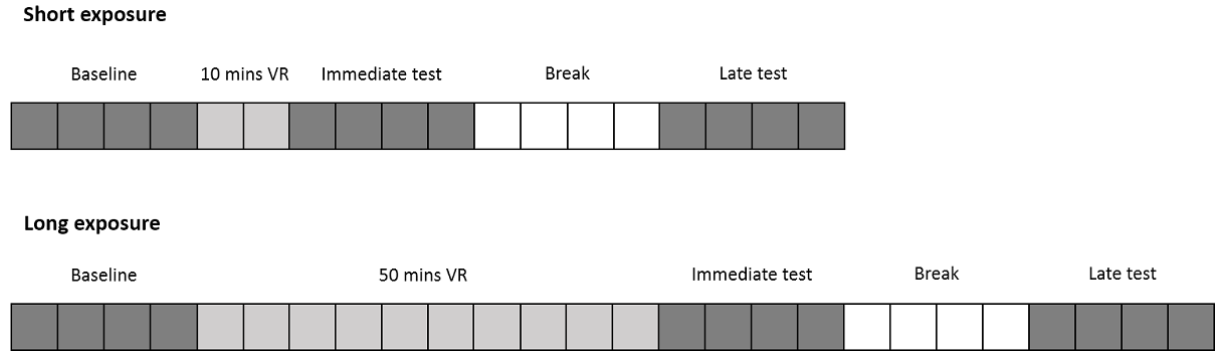
Figure 1. The study design of both days of participation. One square represents 5 min. Dark gray squares represent assessment periods, light gray squares represent virtual reality (VR) exposure, and white squares show when participants took a 20-min break. The order of short and long VR exposures on days 1 and 2 was counterbalanced between